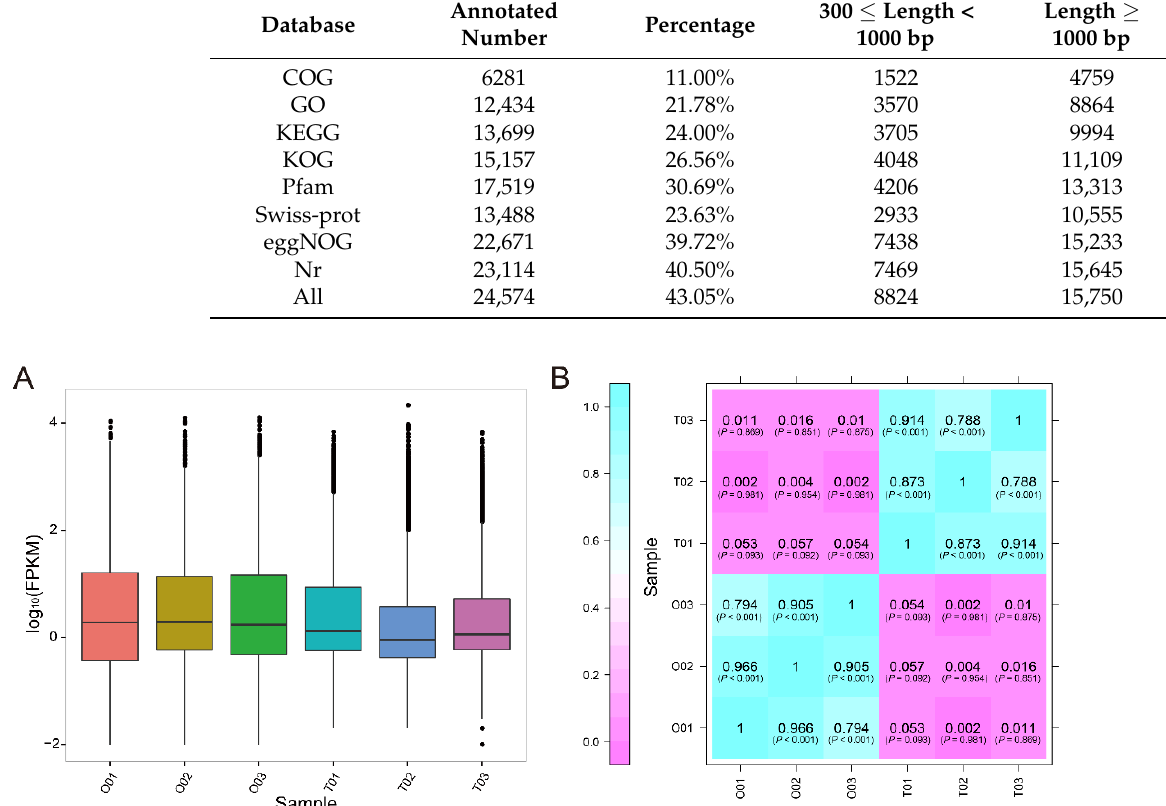
Figure 1. Gene expression pattern analysis in gonads of D. hystrix . ( A ) The distribution of gene expression levels. The horizontal axis indicates sample name, whereas the vertical axis indicates log 10 (FPKM) value. Box plots indicate the maximum, top quartile, median, bottom quartile, and minimum values from top to bottom. ( B ) Heatmap representation of correlations between each two samples. The color represents the correlation coefficient. O, ovary; T, testis.